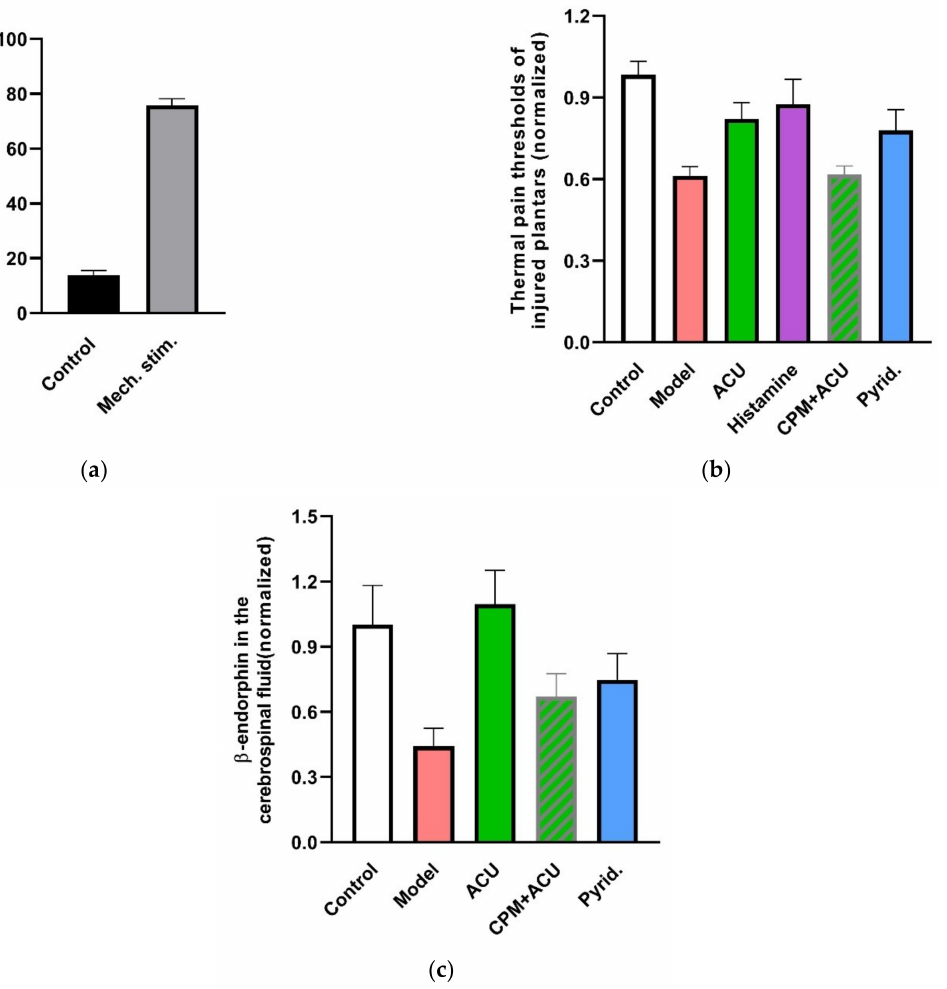
Figure 19. Contribution of histamine and histamine H1 receptors to acupuncture analgesia. ( a ) Mechanosensitive histamine release from HMC-1 cells in response to 240 mOsm-hypotonic shock. Fluorescence intensity in cell supernatants and lyses solutions was determined by fluorescence spectrometer (Hitachi, F-4500) ( λ ex = 350 nm, λ em = 440 nm). Released histamine was calculated as the ratio of fluorescences ( n = 3). ( b ), Effect of histamine and H1 receptors on acupuncture analgesia ( n = 10–13). ( c ) Effect of histamine H1 receptors on β -endorphin level in the cerebrospinal fluid ( n = 7–10). CPM (0.4 mg/mL, 50 µ L), a specific antagonist of H1 receptors, was pre-injected in ST36 5 min ahead of needling ( n = 10). Histamine (100 µ L/mL, 50 µ L) or 2-pyridineethanamine dihydrochloride (Pyrid.) (200 µ g/mL, 50 µ L), a specific agonist of H1 receptors, was injected at the same time point ( n = 10). β -endorphin was determined with ELISA. Establishing the inflammation pain and acupuncture intervention was referred to in the legend of Figure 5. Data are means + SEM and are based on Huang et al. (2010) [89], Zhang et al. (2012) [38] and Huang et al. (2018)